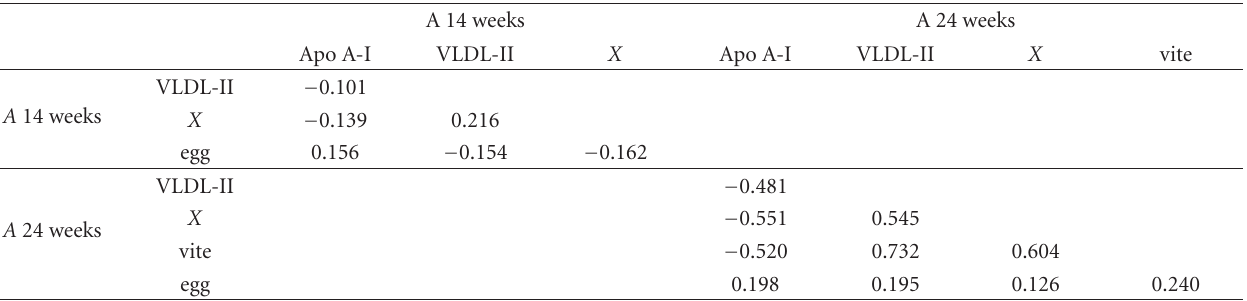
Table 5: The Pearson’s correlation coe ffi cient of A dataset is between serum protein concentrations apolipoprotein A-I, apo VLDL-II, X protein and